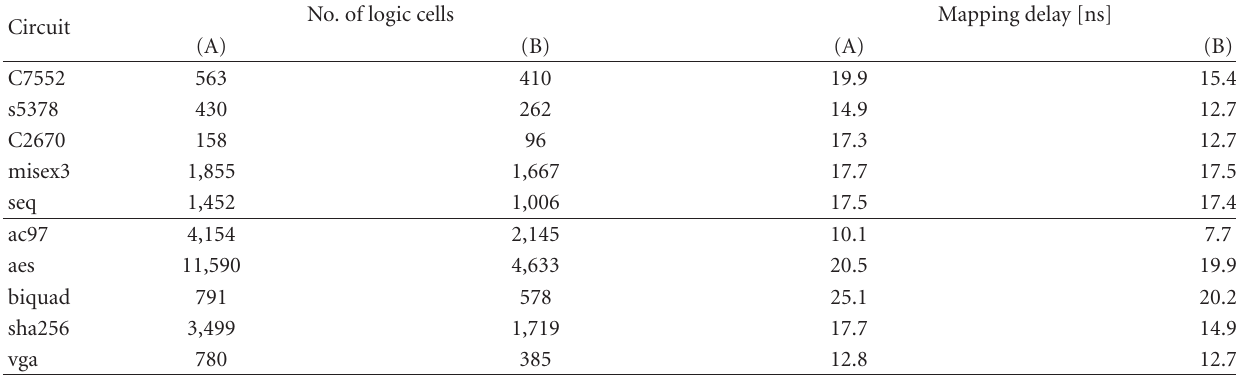
Table 4: Number of logic cells and mapping delay.